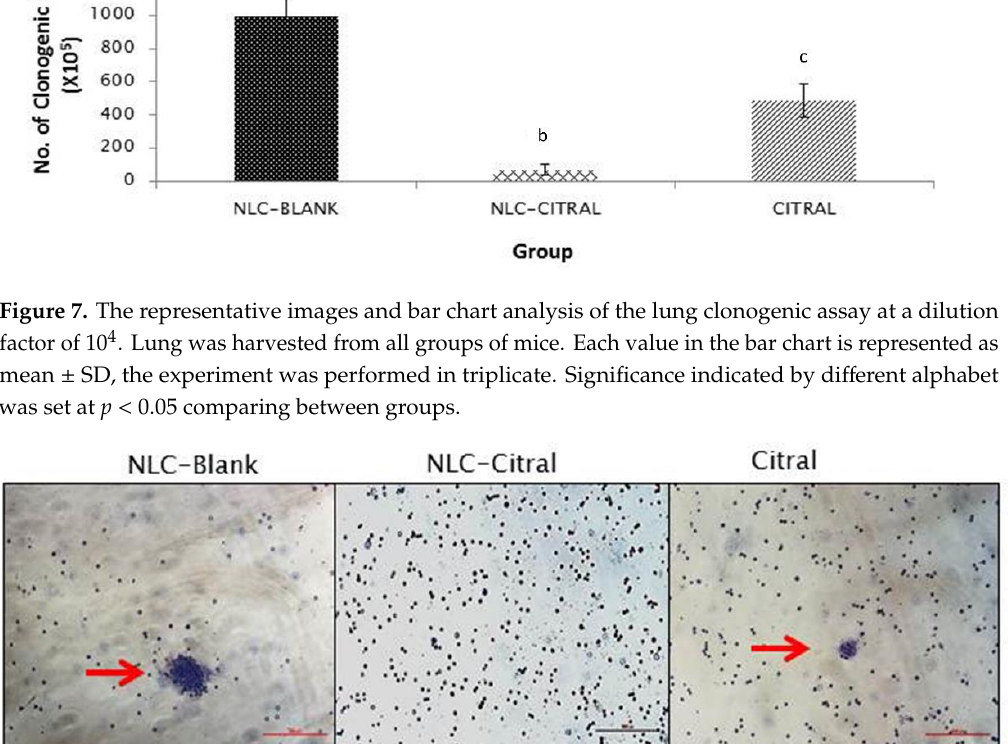
Figure 8. Bone marrow smear from all groups of mice. Images were viewed at 200 × magnification. The red arrow indicates the 4T1 cell that has metastasized into the bone marrow.